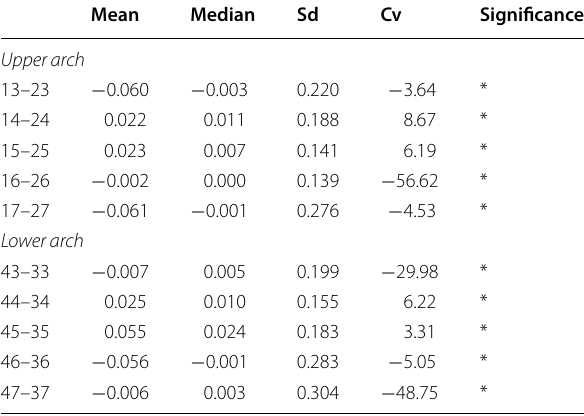
Table 2 Descriptive analysis on the average imprecision of intra- arch distances